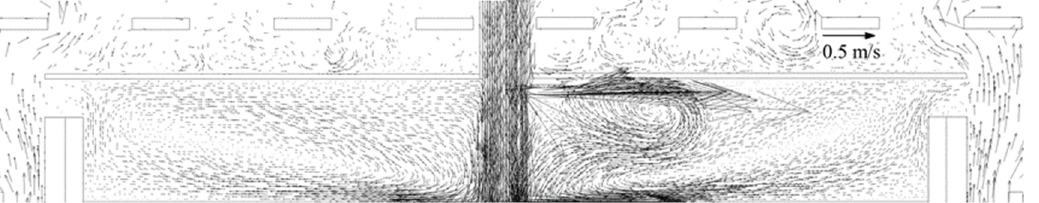
Figure 6. Flow of argon above the free surface at 50% crystalline fraction without ( left ) and with ( right ) AGDS.